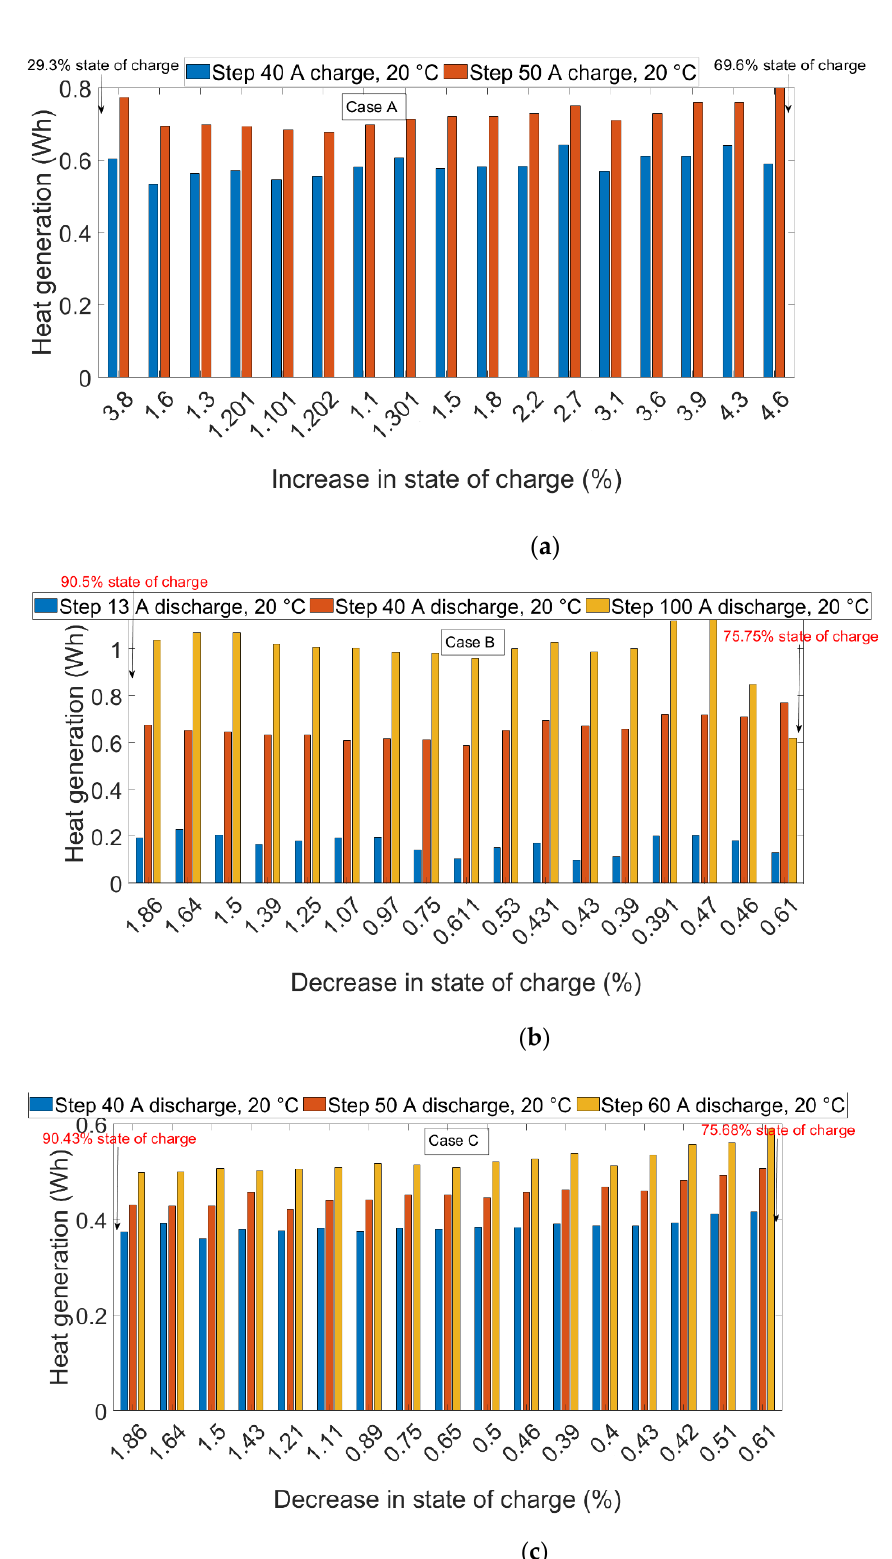
Figure 6. Comparison between different cases during random and periodic charge-discharge pulses :( a ) case A, ( b ) case B, ( c ) case C. ( a ) case A, ( b ) case B, ( c ) case